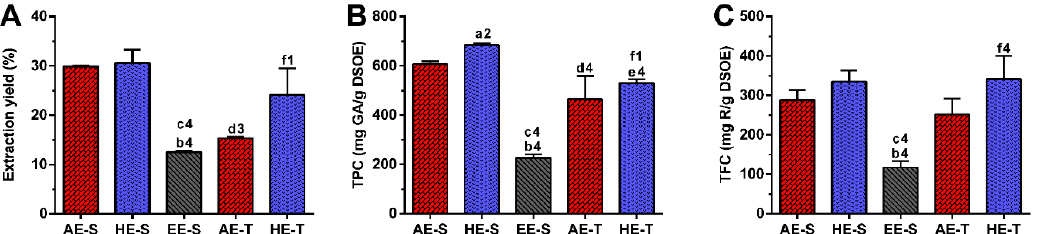
Figure 1. Extracts yield ( A ), total phenolic (TPC) ( B ), and flavonoid (TFC) ( C ) contents of Salvia officinalis extracts. Statistically significant differences are 1 ( p < 0.0257), 2 ( p < 0.0037), 3 ( p < 0.0004), and 4 ( p < 0.0001) in comparison with a (AE-S vs. HE-S), b (AE-S vs. EE-S), c (HE-S vs. EE-S), d (AE-S vs. AE-T), e (HE-S vs. HE-T), and f (AE-T vs. HE-T). GA: gallic acid; R: rutin; DSOE: dry